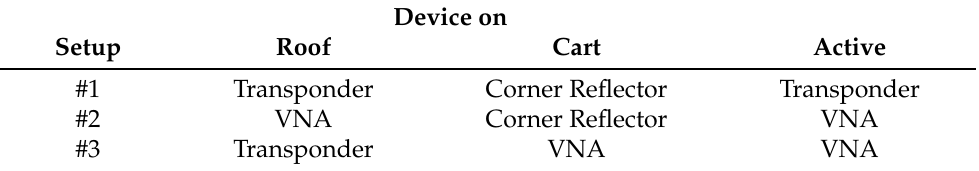
Table 1. Summary of measurement setups used to conduct the calibration